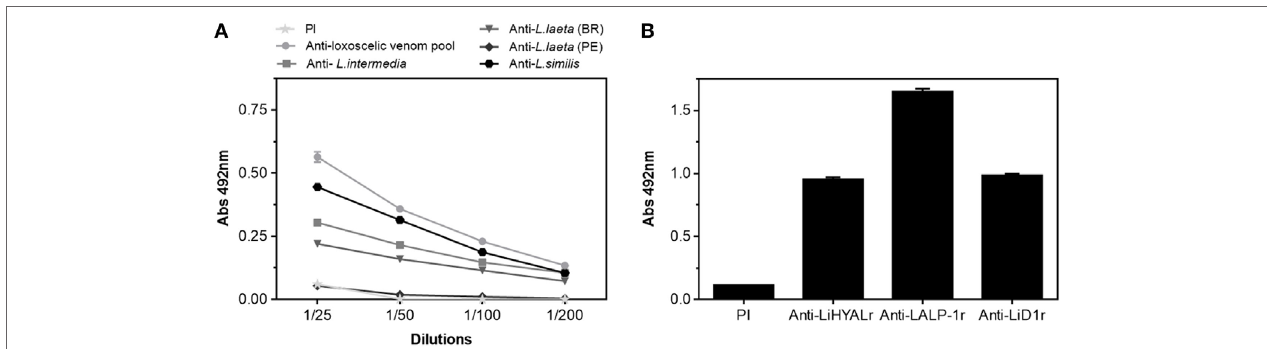
FigUre 5 | Immunoreactivity of the rMEPLox by ELISA. The plates were coated with rMEPLox 5 µg/mL. Pre-immune (PI) sera was used as negative control. (a) ELISA showing the reaction of rMEPLox with antibodies developed against a pool of loxoscelic venoms or individual venoms from L. intermedia , Loxosceles laeta (Brazil), L. laeta (Peru), and L. similis (serially diluted 1/25 to 1/200). (B) ELISA showing the reaction of rMEPLox against anti-LALP-1, anti-LiHYAL, and anti-LiD (diluted 1/200) ELISA and values given are the means of duplicates. The absorbance of the samples was determined at 492